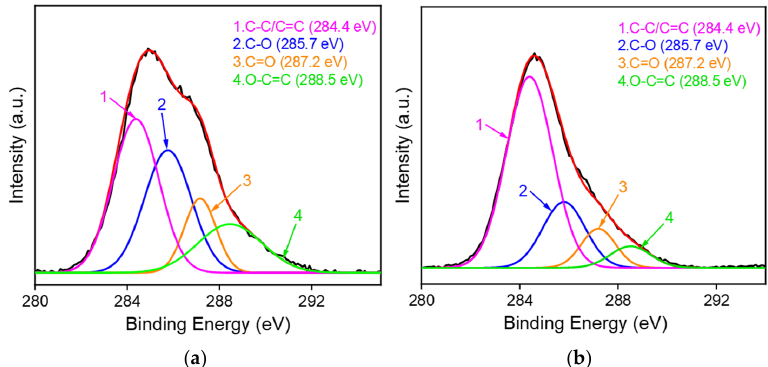
Molecules 2022 , 27 , x FOR PEER REVIEW Figure 2. Carbon 1s XPS profiles of ( a ) GO/SPCE and ( b ) ErGO/SPCE. Figure 2. Carbon 1s XPS profiles of ( a ) GO/SPCE and ( b ) ErGO/SPCE. Figure 2. Carbon 1s XPS profiles of ( a ) GO/SPCE and ( b ) ErGO/SPCE.